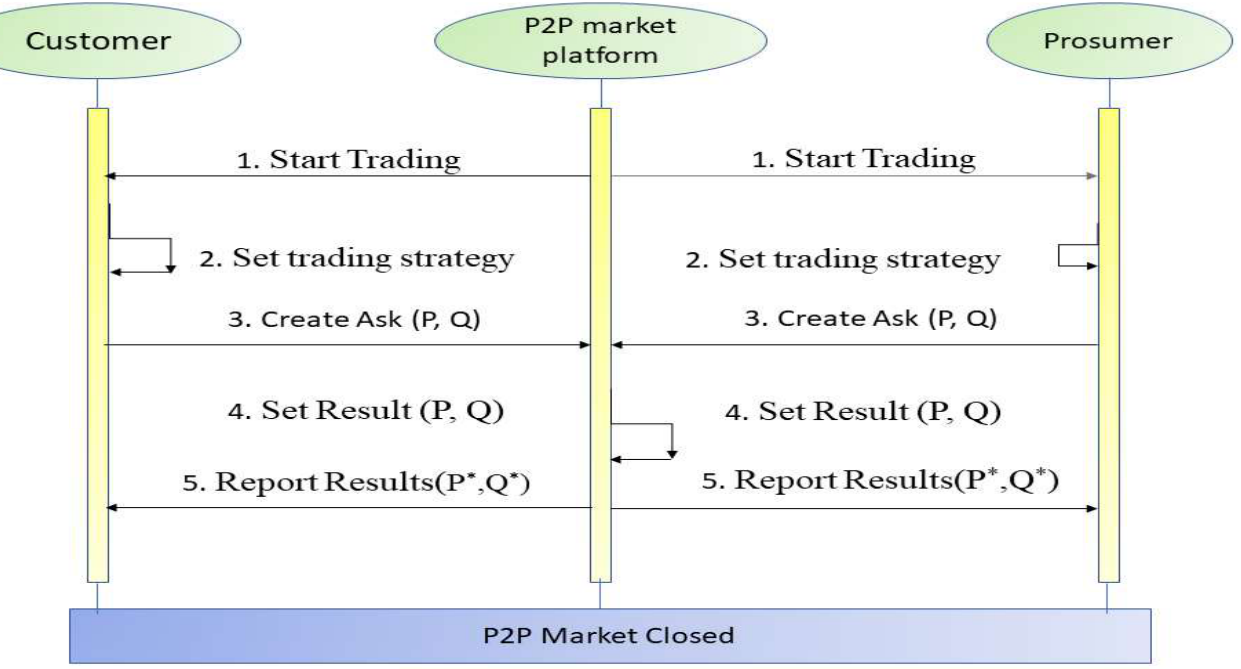
Figure 6. Sequence diagram illustrating synchronous energy pricing for P2P energy trading. (P, Q: bidding price and volume, respectively; P*, Q*: determined energy price and volume, respectively).